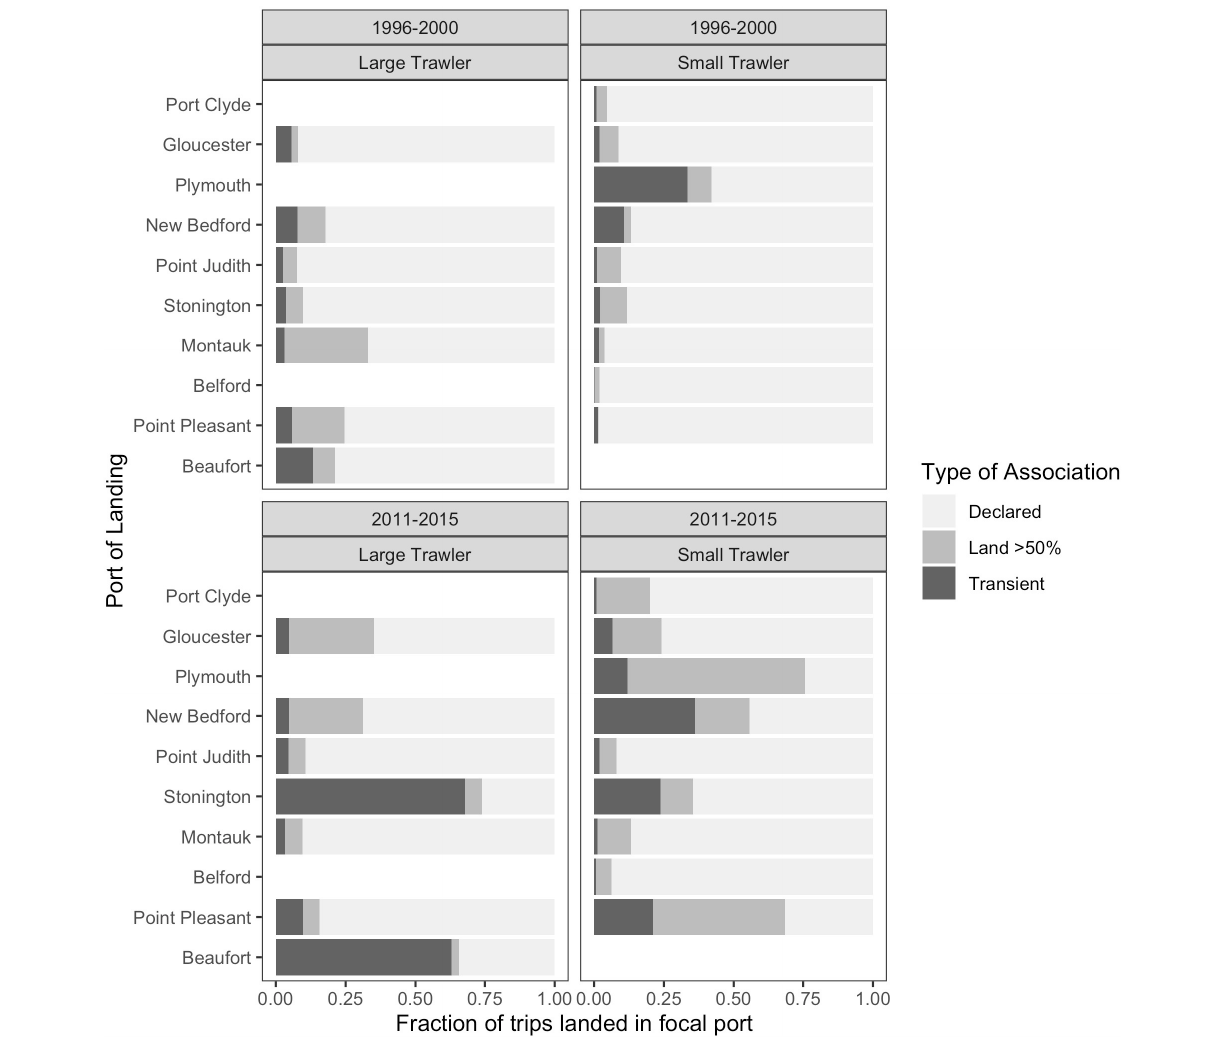
FIGURE 13 | For trips landed in each focal ports, the fraction of the total trips made by vessels with each type of association with the port:: vessels that have declared the port as a home port (“Declared,” light gray), those that land at least 50% of their trips in that port in that year (“Land > 50%,” medium gray) or transient vessels that have neither type of association (“Transient,” dark gray). (top) baseline period 1996–2000; (bottom) recent period 2011–2015; (left) large trawl communities; (right) small trawl communities. This represents the degree to which a port “receives” trips from other